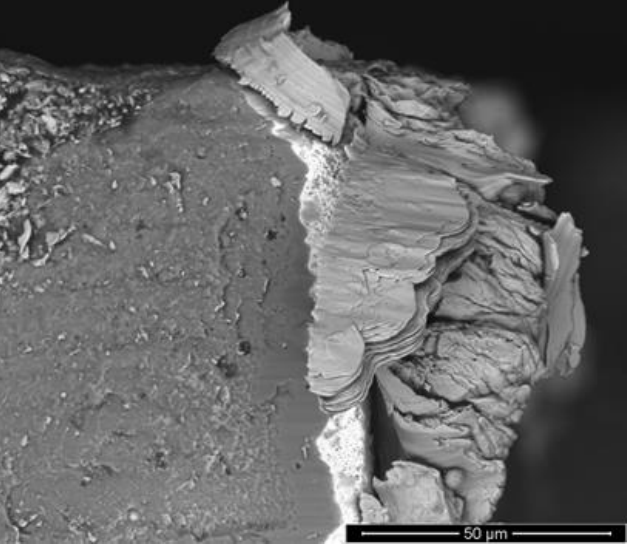
Figure 14. Built-up edge detected on the clearance face of a T3 tool, tested at 125% feed rate. Other wear mechanisms were identified, being the same as the reported in the previ- ously mentioned tools. There was evidence of abrasive wear and coating delamination, as seen in Figure 15. This delamination was promoted by the high amount of material adhe- sion and abrasion of the workpiece material on the tool’s surface. The material adhesion promoted abrasive wear on these adhesion zones, eventually resulting in the spalling of the tool’s coating (through adhesive